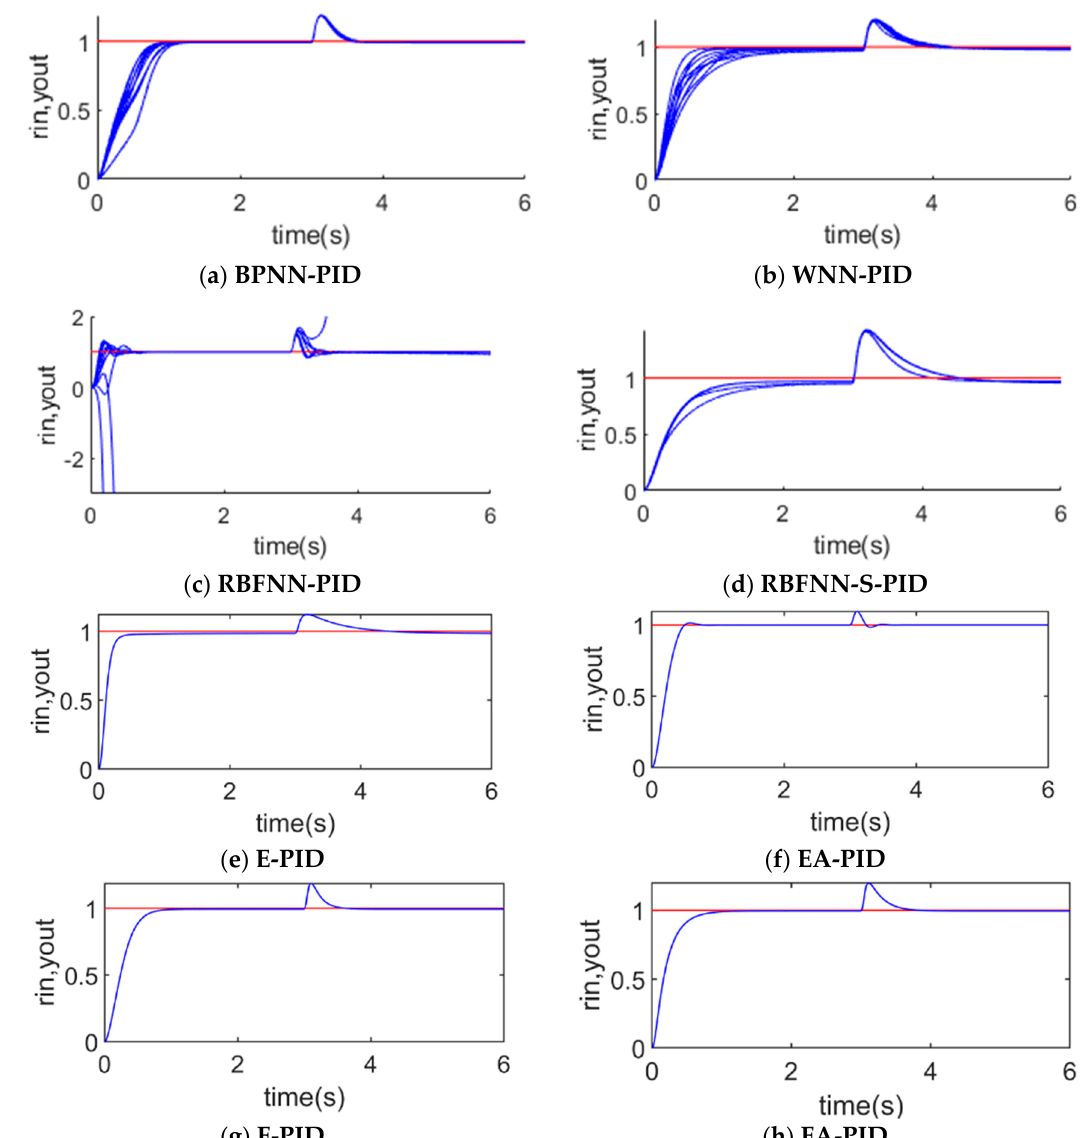
Figure 10. Comparison for robust (anti-interference) analysis: ( a ) BPNN-PID; (b) WNN-PID; (c) RBFNN-PID; (d) RBFNN-S-PID; (e) E-PID; (f) EA-PID; (g) F-PID; (h) FA-PID.